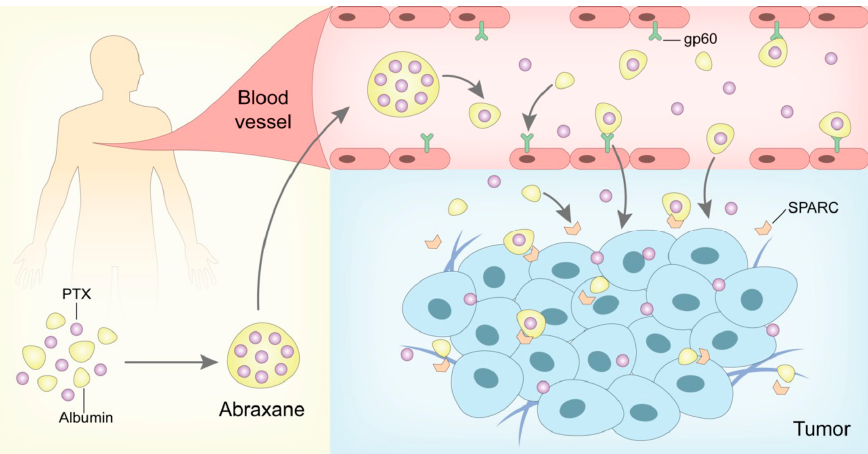
Figure 3. In vivo antitumor mechanism of Abraxane ® . After the intravenous infusion, Abraxane ® could highly deliver the encapsulated PTX via albumin carrier and enhance the PTX distribution in tumor tissues mediated by gp-60 and SPARC, which has been applied in the treatment of several kinds of malignant melanoma.